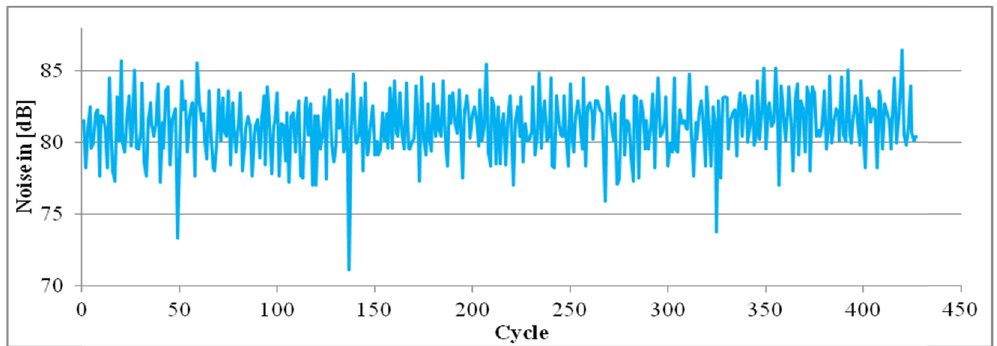
Figure 5: The background noise chart attained by running the motion generating part of the simulator and without load.